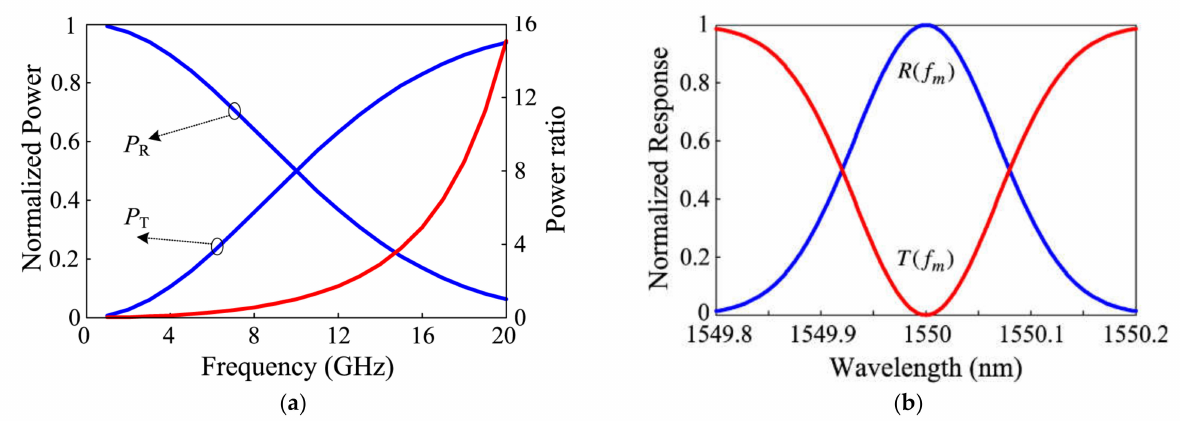
Figure 3. Simulation results of a Gaussian-shaped FBG example: ( a ) Dependence of the detected optical power and power ratio on the input microwave frequency; ( b ) Normalized frequency response of the FBG (Adapted with permission from Ref [25]. Copyright 2010, Elsevier).